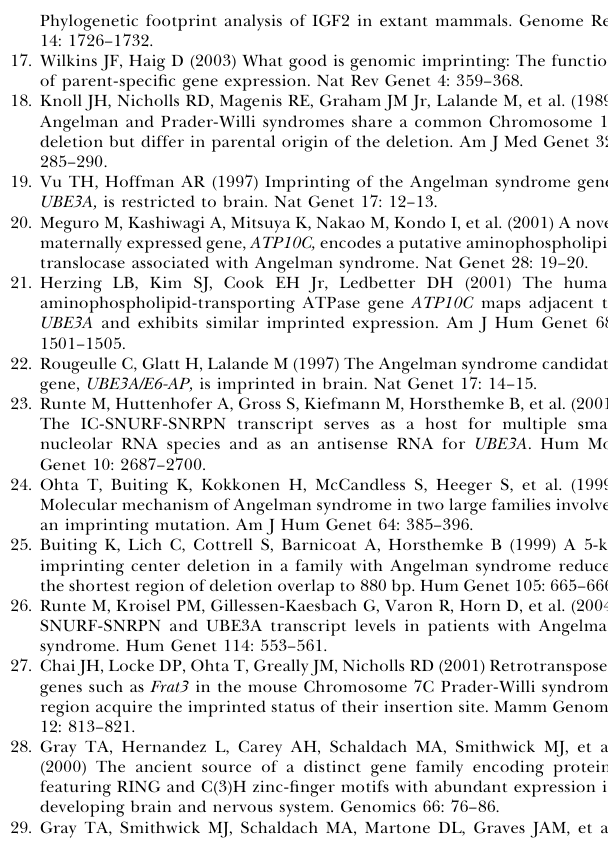
Figure S1. Relationships between Vertebrate Sm Proteins Encoded by the Genes SNRPN (SmN) and SNRPB/B 9 (SmB) Generated Using Maximum Parsimony Analysis Marsupial (opossum and tammar) SmN sequences are sister to placental SmN and distant from vertebrate SmB. Support for tree topology is indicated by bootstrap values (1,000 replicates). Figure S2. Primer Extension Assay Relative allelic concentrations of PCR products amplified from the UBE3A gene of platypus brain genomic DNA and cDNA for the three individuals sampled. Standard deviation indicated by error bars. Table S1. Human Protein Sequences Used in Study Found at DOI: 10.1371/journal.pgen.0020182.st001 (37 KB DOC). Table S2. Location of Putative Orthologs Aligned to Human Proteins of Interest in Mouse, Dog, Opossum, Tammar Wallaby, Platypus, Chicken, and Zebrafish Percent identity between query and target sequence is given, along with the coverage of this alignment relative to query sequence length. An asterisk (*) denotes that no significant alignment was found. % Id, percent identity; % cov, percent coverage.